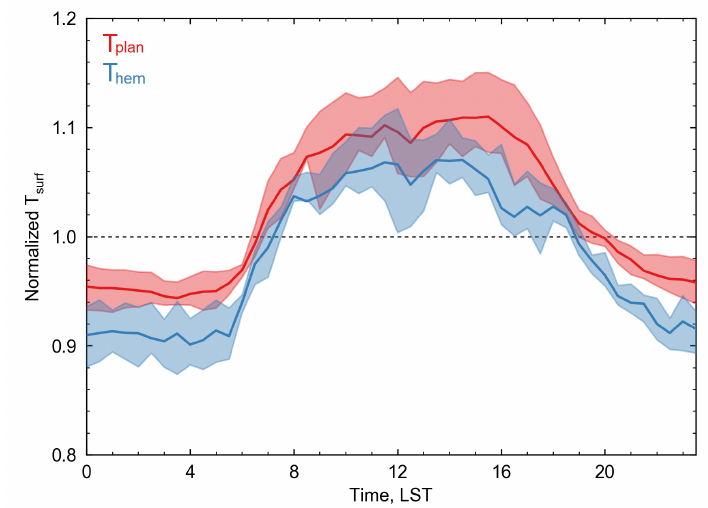
Figure 12. A comparison of mean T hem, r and T plan normalized by T comp at 30 min intervals from 26 June 2002 through 9 July 2002 during the intensive observation period. Shading indicates the area bounded by the first and third quartiles; n = 14